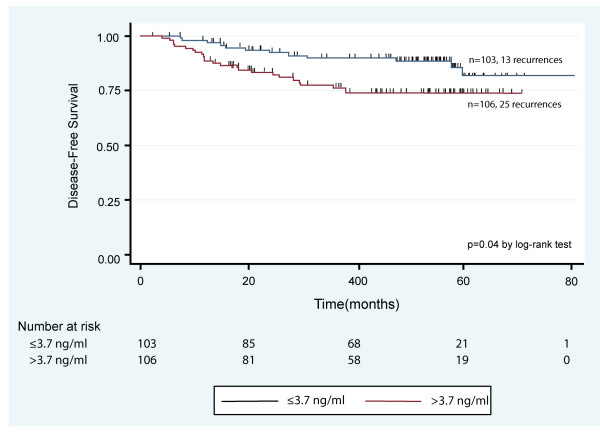
Kaplan-Meier plot for disease-free survival comparing patients with HU177 concentrations above and below the median value. [178].